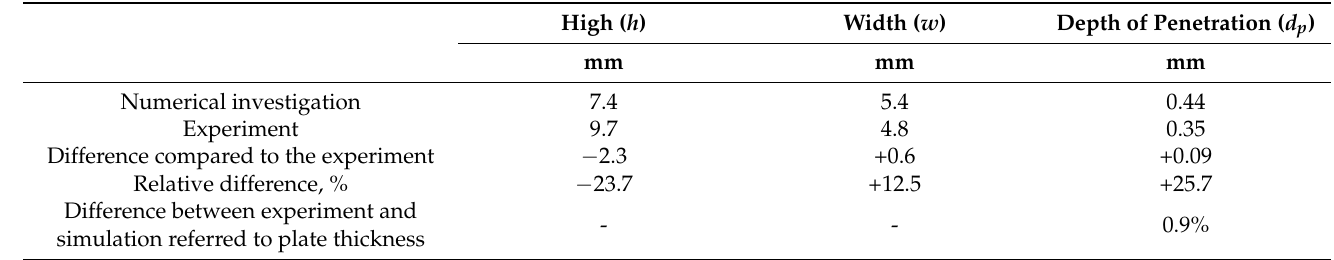
Table 4. Dimensions of the trace after 56 × 45 mm HC (SS109) projectile impact onto Armox 600 armour